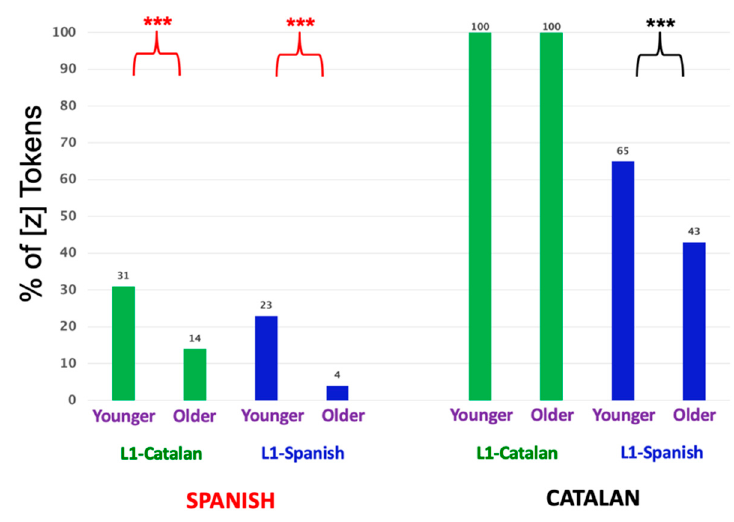
Figure 10. Effect of age as mediated by language profile and language on Barcelonan fricative production.